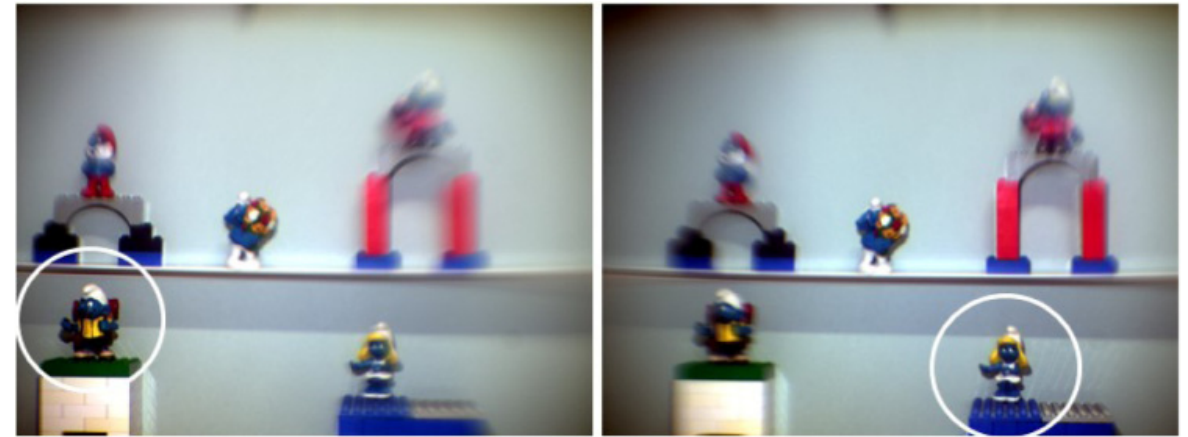
Figure 18. Simulation of saccades using the eye model of Förster et al. For each image, the pivot axes of the optical group is pointing in a different direction, so that for each individual image a different part of the scene is highly resolved (highlighted by a white circle. Optics Express 2015, 23, 929 ([54]). Originally published by and reprinted with permission from Optica Publishing Group.